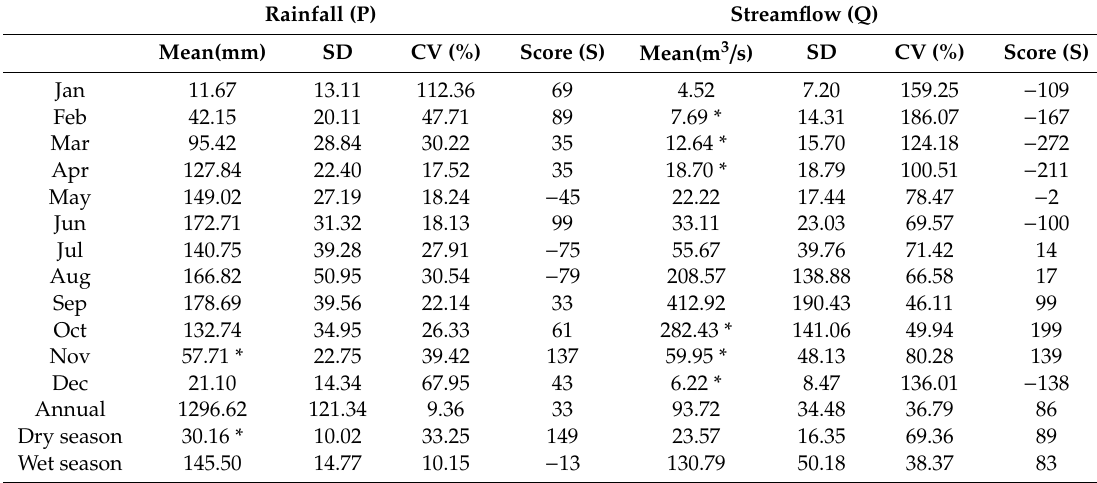
Table 1. Basic statistics of monthly and annual GPCP rainfall (mm) over Bandama basin and streamflow(m 3 / s) at Kossou station